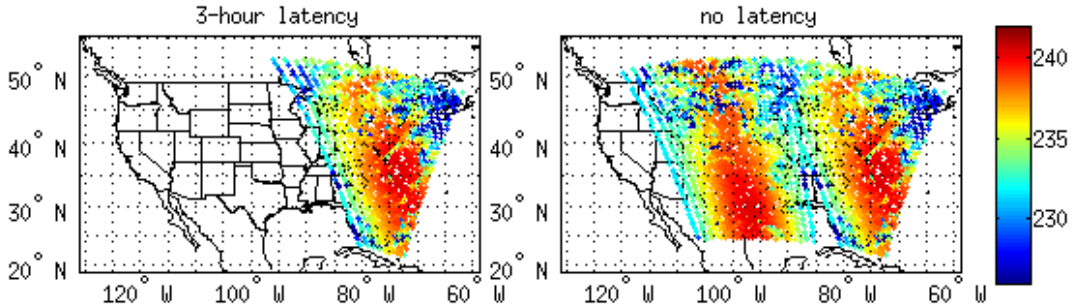
Figure 2. Channel 96 of CrIS data coverage for the 2-hour latency and 1-hour latency at 1800 UTC 23 June, 2018.